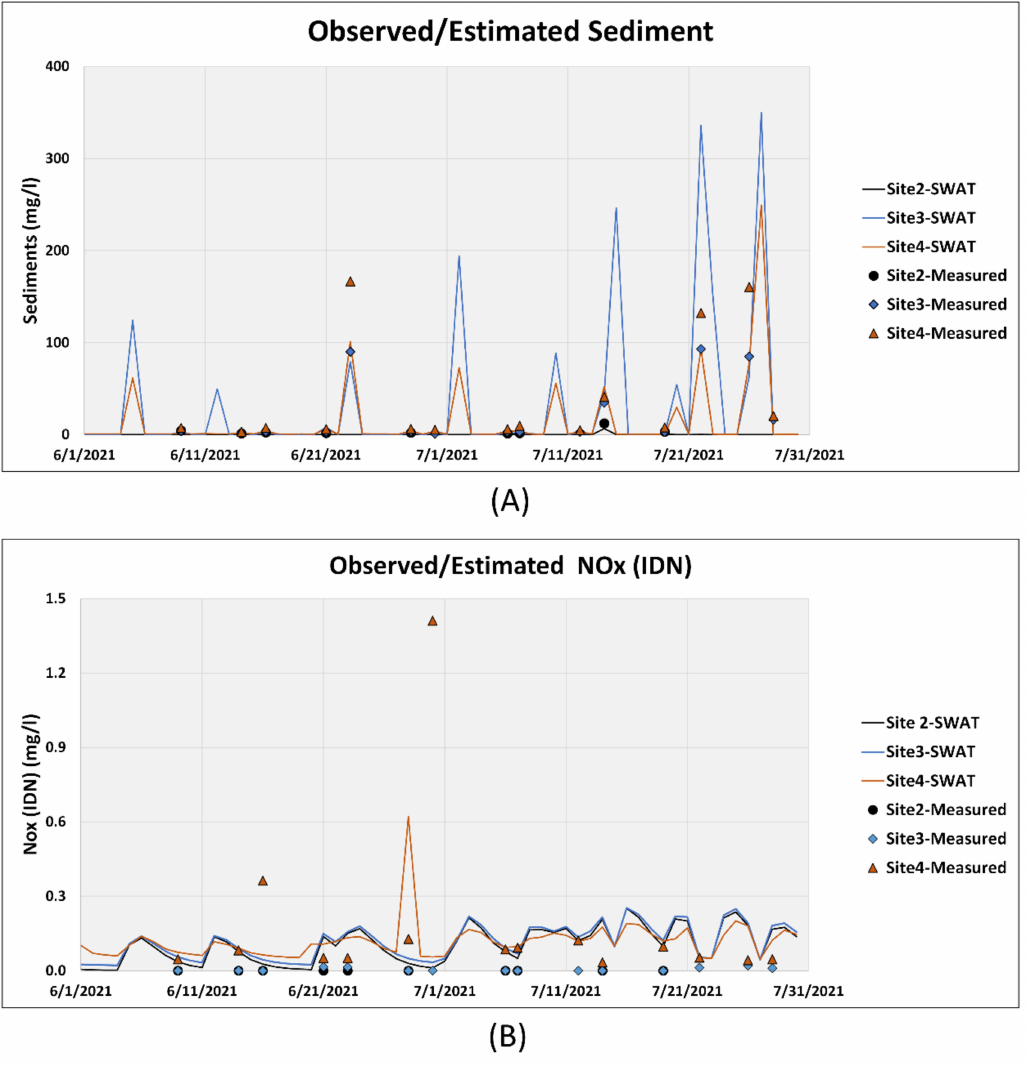
Figure 10. Comparison of the sediments ( A ) and IDN ( B ) estimated by the calibrated SWAT model with the measured values for the period of 1 June to 31 July